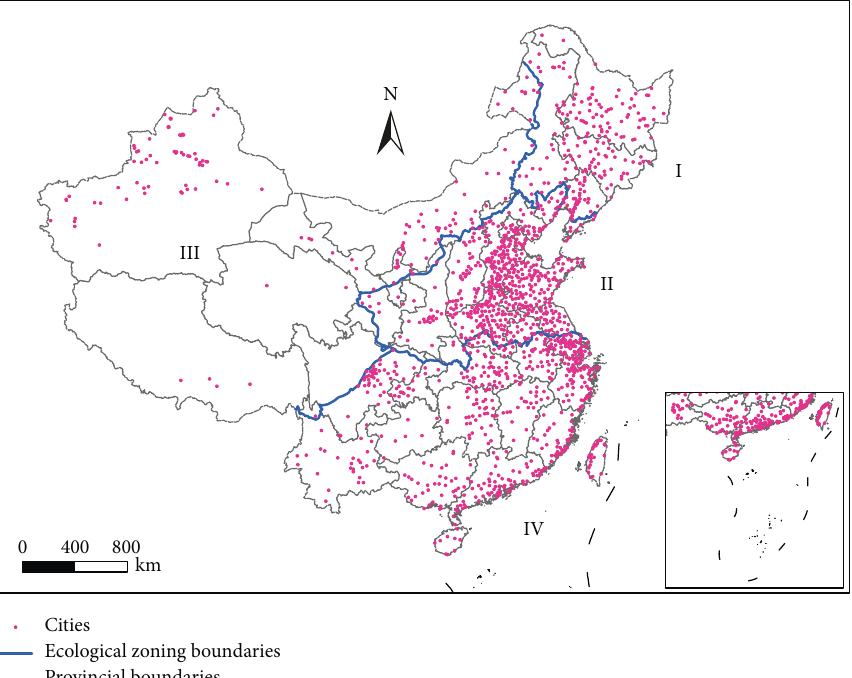
Figure 1: Locations of the 1449 cities selected for this study in the four environmental